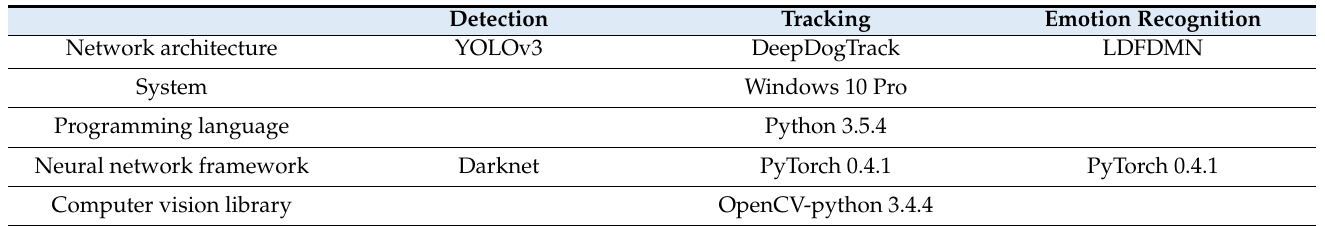
Table 4. Software. Table 4.